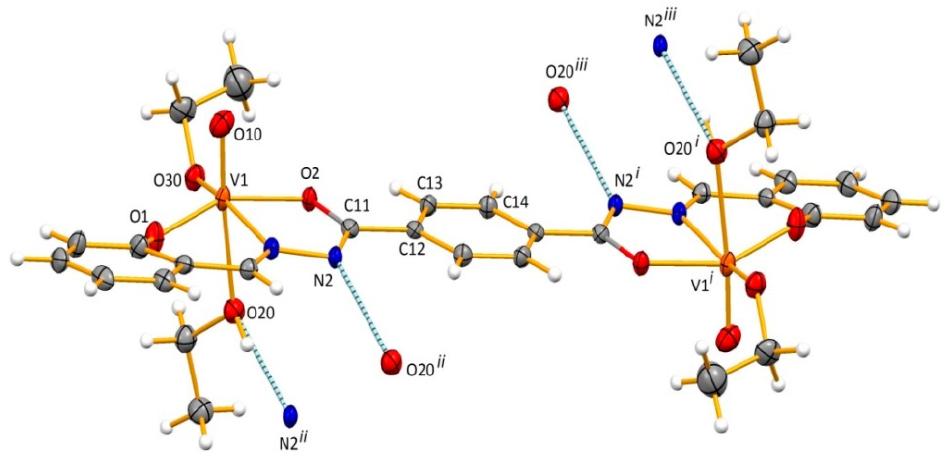
Figure 28. Structure of complex 31 (C 30 H 36 N 4 O 10 V 2 ) Adapted from Ref. [150], Copyright (2013) with permission of Royal Society of Chemistry.